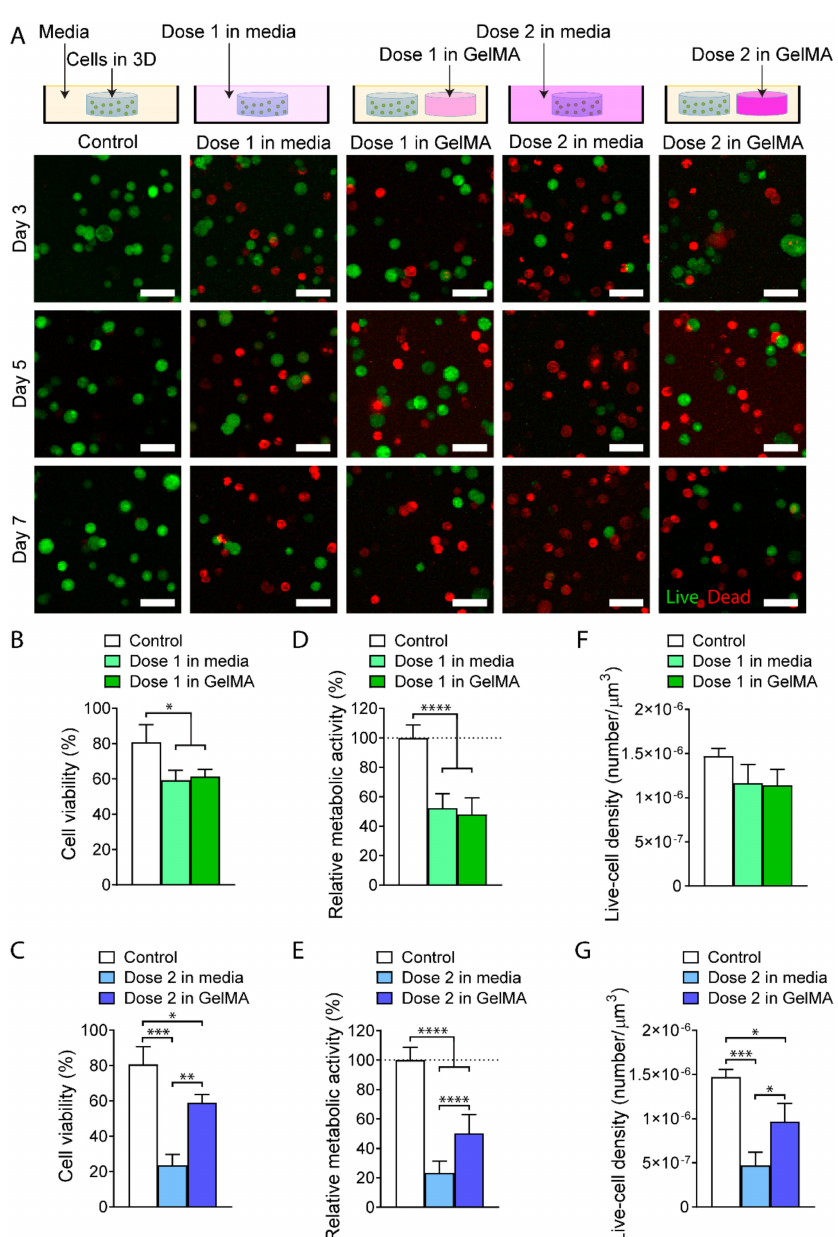
Figure 6. In vitro evaluation of GelMA-DDS 10% on human MDA-MB-231 breast cancer cells cultured in separate three-dimensional (3D) GelMA hydrogels. ( A ) Maximum projections of z stacks with live / dead staining using Fluorescein Diacetate (FDA) and Propidium Iodide (PI) of cancer cells for five media conditions; no drug (control), Dose 1 free in solution, Dose 1 in GelMA, Dose 2 free in solution, and Dose 2 in GelMA (from left to right). Green represents live cells, and red represents dead cells. Scale bar = 50 µ m. GelMA ( B – G ) Quantitative in vitro assessment of GelMA-DDS formulations at Day 7; viability ( B – C ), metabolic activity ( D – E ), and Live-cell density ( F – G ) for no drug control, drug in media and drug in GelMA. Data are shown as mean ± standard deviation. The experiment was repeated three times, n = 3. **** p < 0.0001; *** p < 0.001; ** p < 0.01; * p <